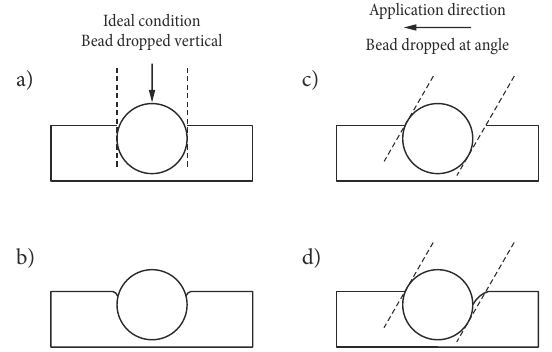
Figure 1. Different bead embedment illustration (Rasdorf et al.